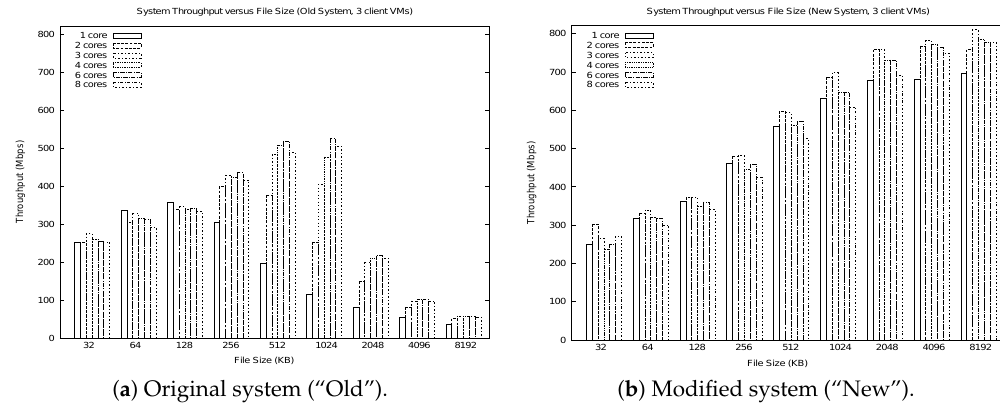
Figure 1. RTEMP system throughput versus file